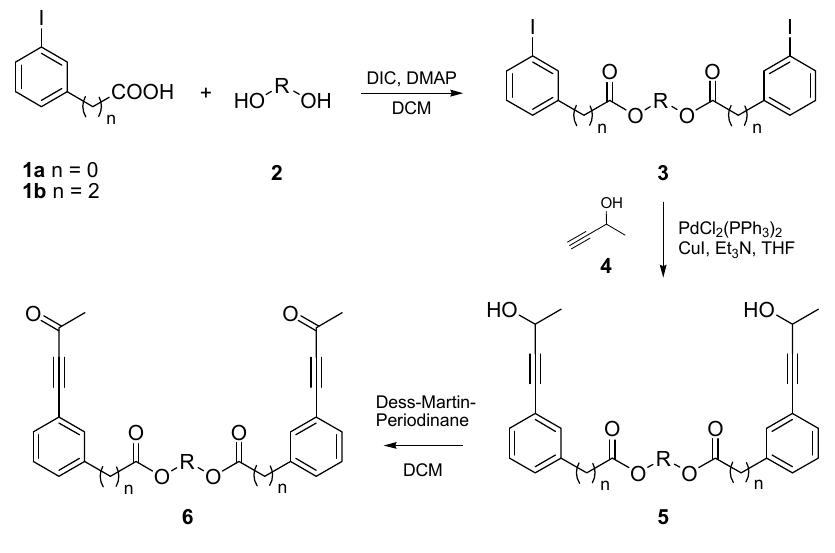
Scheme 1. Synthesis of PDDA reactants 6